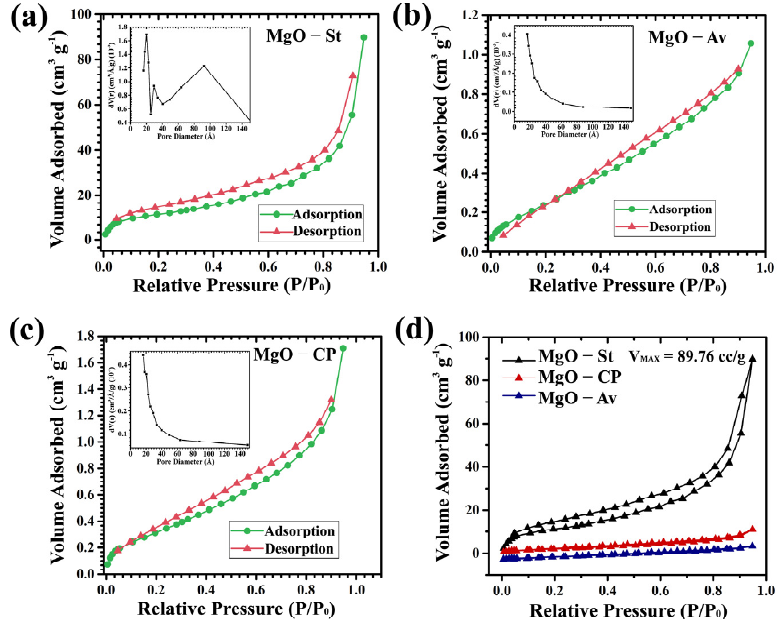
Figure 3. Adsorption and desorption isotherms with pore size distribution (inset) of MgO samples: ( a ) starch, ( b ) Aloe vera , ( c ) citrus pectin, and ( d ) comparison of the maximum volume of adsorbed N 2 .